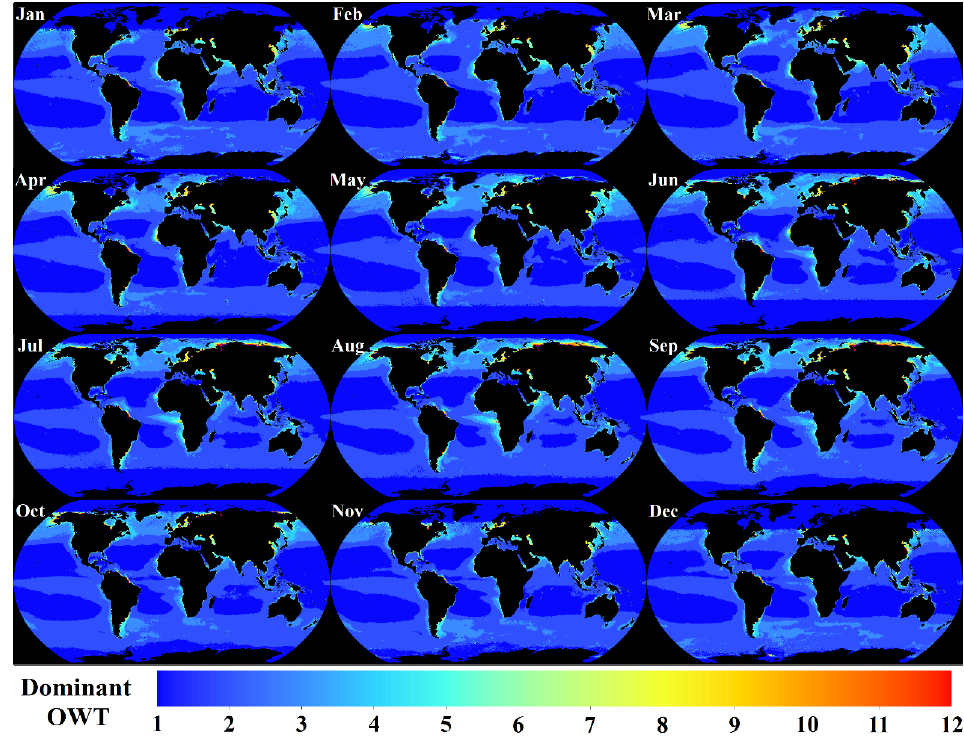
Figure 15. Global U-OWT dominant OWT monthly variability based on the ESA-OC-CCI v4.2 climatology monthly R rs (1998–2019).